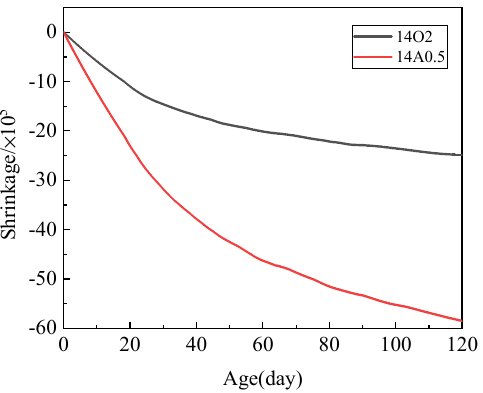
Figure 6. Shrinkage of pastes prepared using MgO calcined at 1450 °C, cooled in air and in the oven.